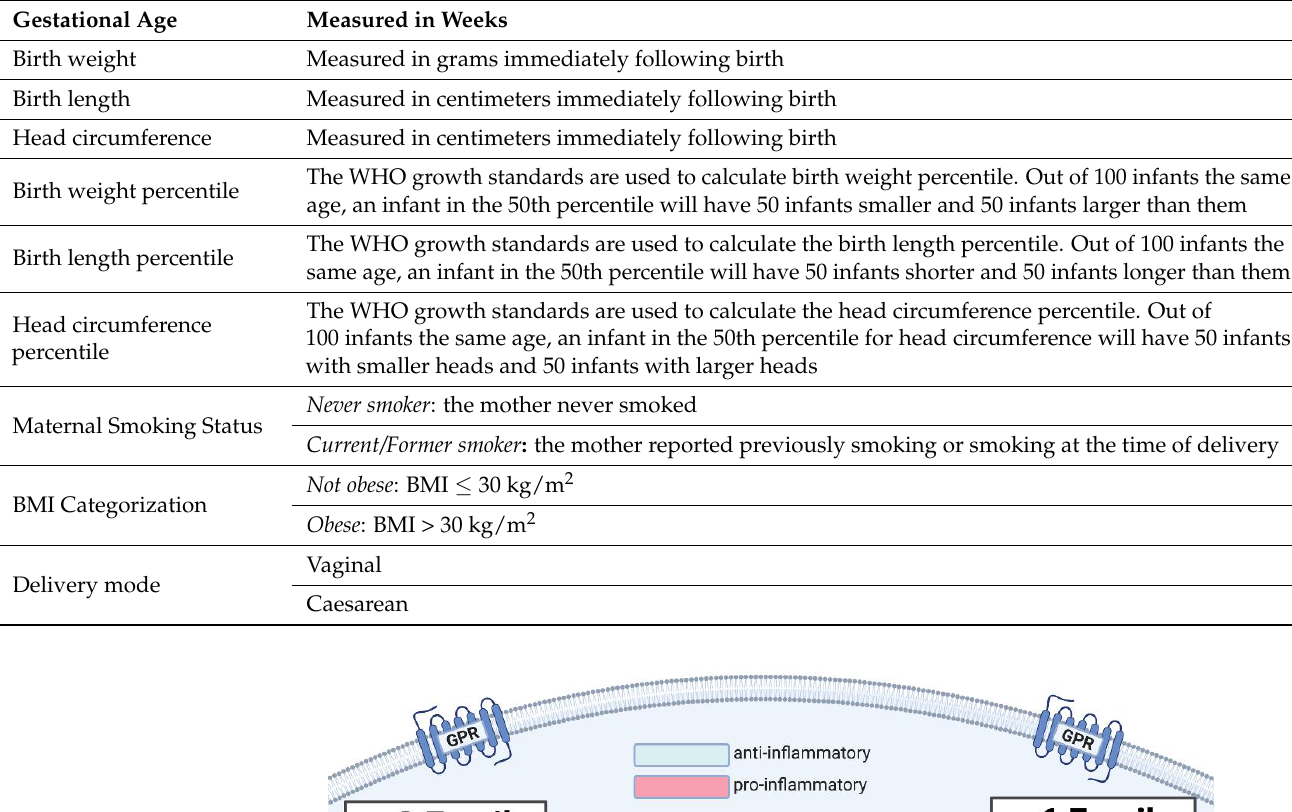
Table 11. Description of maternal and infant outcomes collected from the EMR.